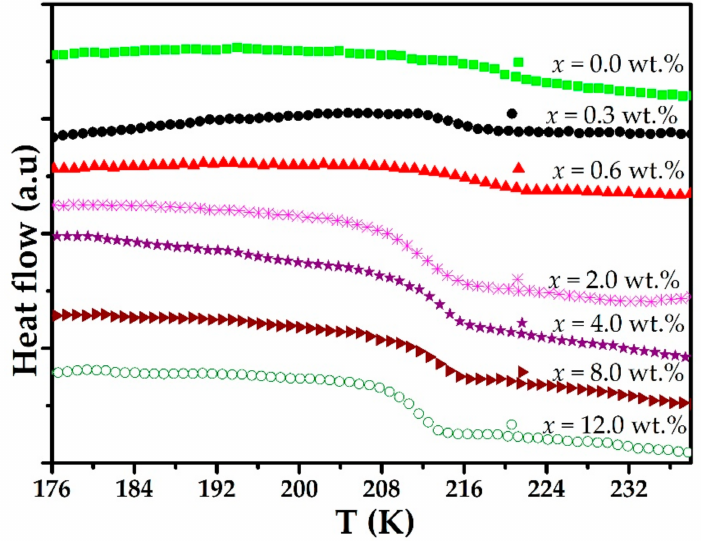
Figure 1. DSC thermograms for (PEO)4CF3COOLi + x % MWCNT composite ( x = 0.0%, 0.3%, 0.6%, 2.0%, 4.0%, 8.0%, and